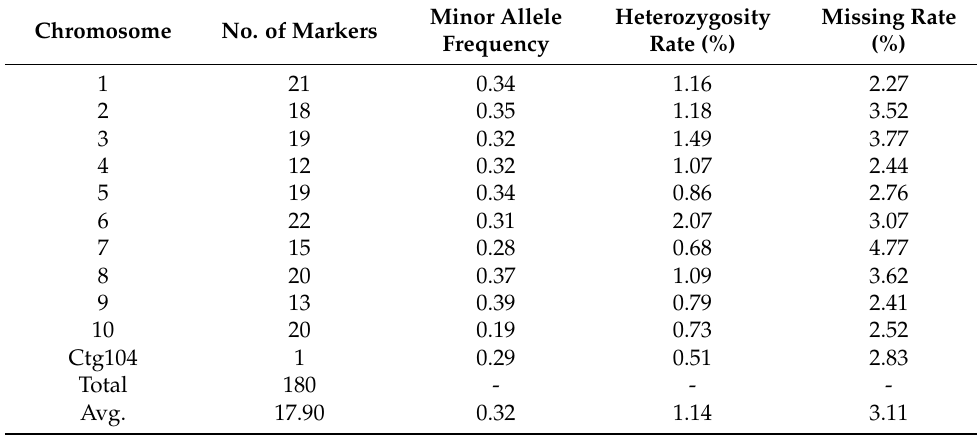
Table 1. Summary statistics for the 180 KASP markers in the first round of genotyping.